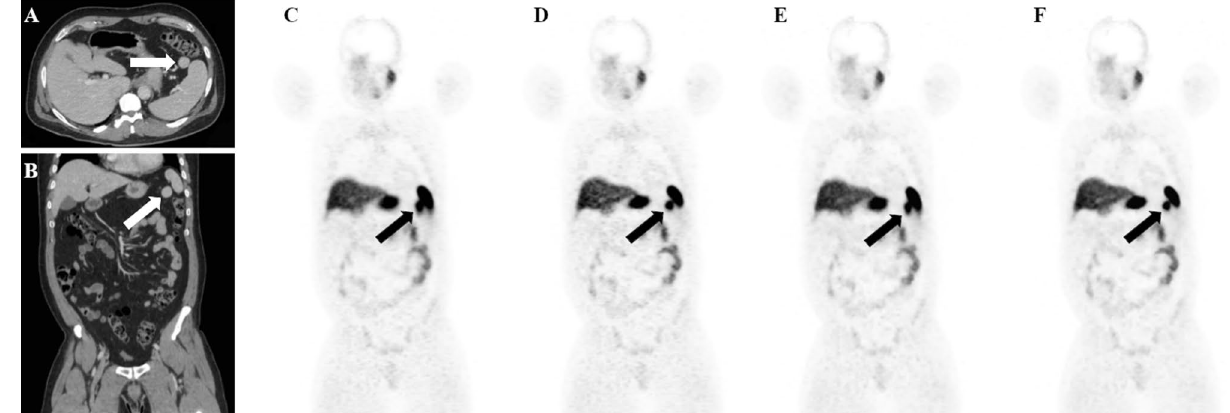
The relationship between SUVmax and PET volume for accessory spleen, IPAS and pNET separately in each reconstruction (OSEM, OSEM-DDG, BSREM and BSREM-DDG) is shown in Fig. 5. The ability of quantitative PET parameters of 68 Ga-DOTATATE PET/CT to differentiate pNET and IPAS as well as accessory spleens was assessed using a ROC analysis with and without DDG (Fig. 6). NET are a heterogeneous group of tumors and the uptake of 68 Ga-labeled somatostatin analogue is higher in well-differentiated NET compared to poorly-differentiated NET, and correlates strongly with SSTR 2A receptor expression 42,43 . As shown in Fig. 3a, uptake of accessory spleens was rather homogeneous and was associated with the size of these organs. For this reason, we aimed to identify an SUVmax cut-off in each reconstruction to discriminate pNET and IPAS with a specificity of 100%, in order to avoid false positives. ROC results were considered only if AUC was > 0.70. OSEM-DDG and BSREM-DDG yielded good AUC (all > 0.84), while OSEM and BSREM yielded at least fair AUC (all > 0.73). Cut-offs of SUVmax that discriminate pNET and IPAS with 100% specificity were as follows: